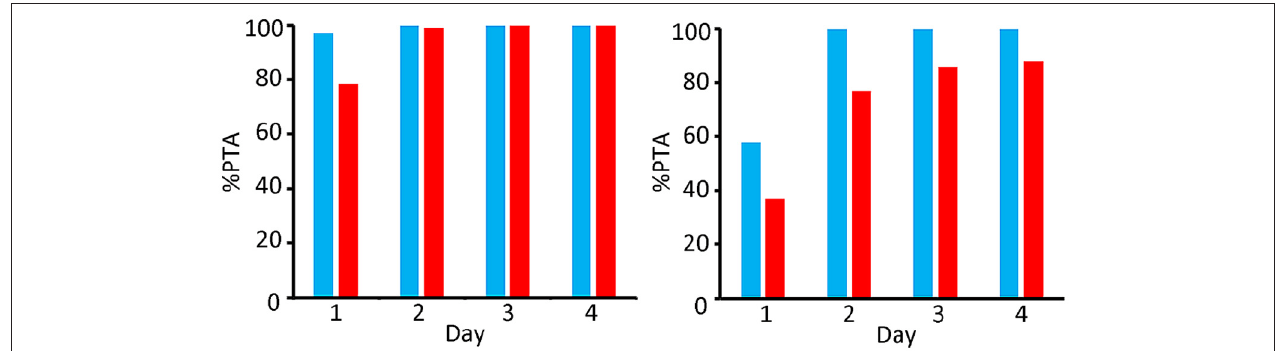
FIGURE 7 | Comparison of PTA [%] for bacteriostatic effectivity (left) and bactericide effectivity (right) of OTC for M. Haemolytica in 400kg (blue) and 100kg (red) steers; dosing regimen 10 mg/kg per day during 4 consecutive day.